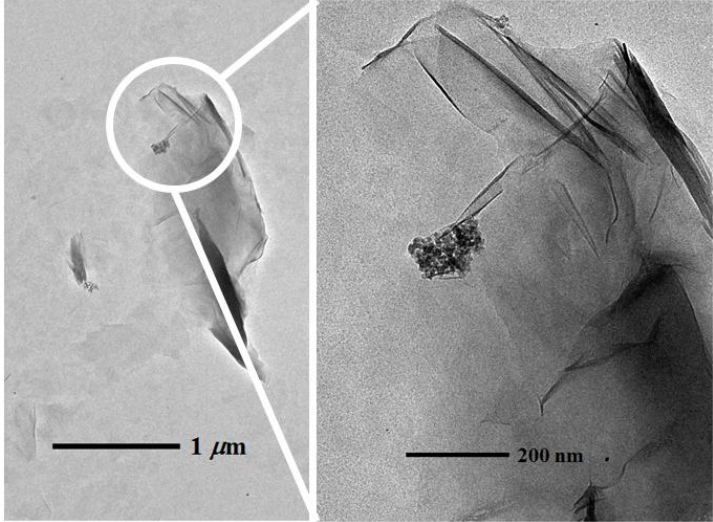
Figure 8. Bright field TEM images of 10 nm γ -Al 2 O 3 NPs with montmorillonite at pH > PZC of Al 2 O 3 NPs.